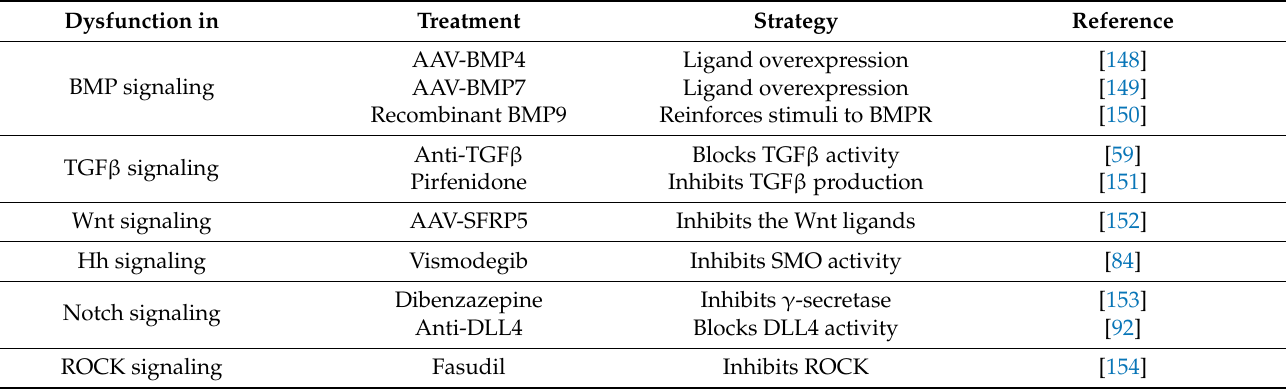
Table 3. Highlights in experimental therapeutics against